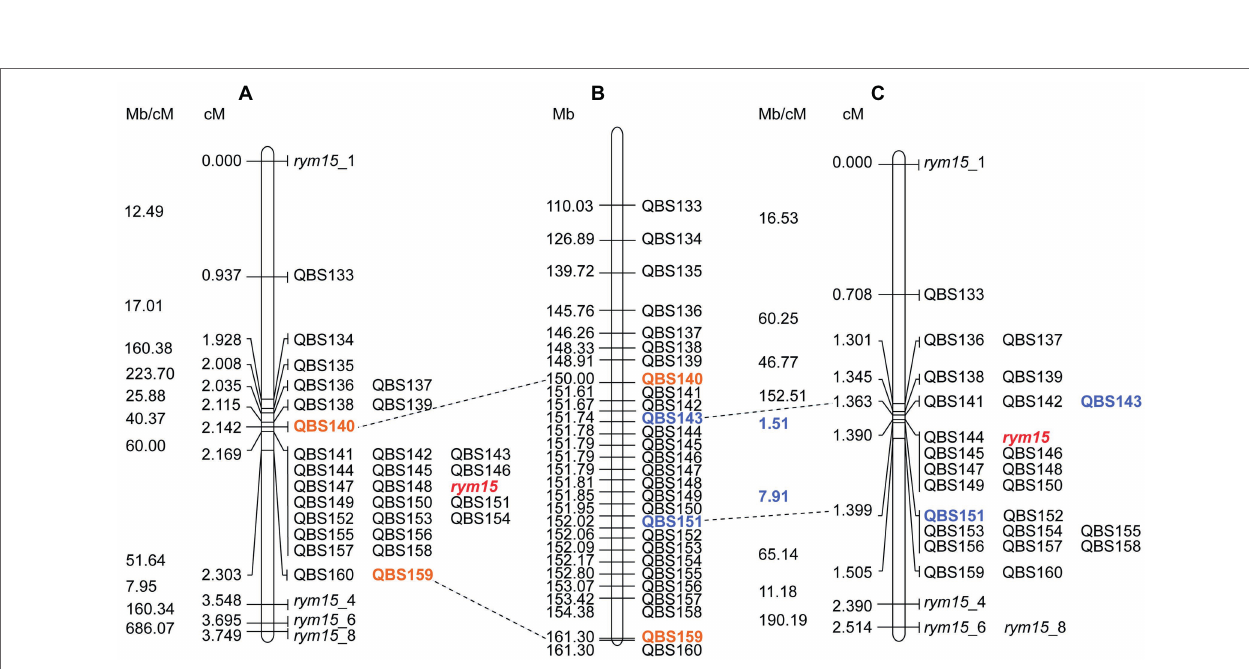
FIGURE 2 | High-resolution genetic maps of rym15 and physical map of barley chromosome 6HS. (A) High-resolution map of rym15 based on a set of 139 F 4 RILs in the population Igri×Chikurin Ibaraki 1. (B) Physical map of Morex on chromosome 6HS according to Morex v3. (C) High-resolution map of rym15 based on a set of 284 F 4 RILs in the population Chikurin Ibaraki 1 × Uschi. The recombination rates (Mb/cM) are listed left of the genetic maps for both populations. The target gene rym15 is highlighted in red and the flanking markers are shown in orange (Igri×Chikurin Ibaraki 1) and blue (Chikurin Ibaraki 1 × Uschi). Crucial recombination events in the population Chikurin Ibaraki 1 × Uschi are highlighted in